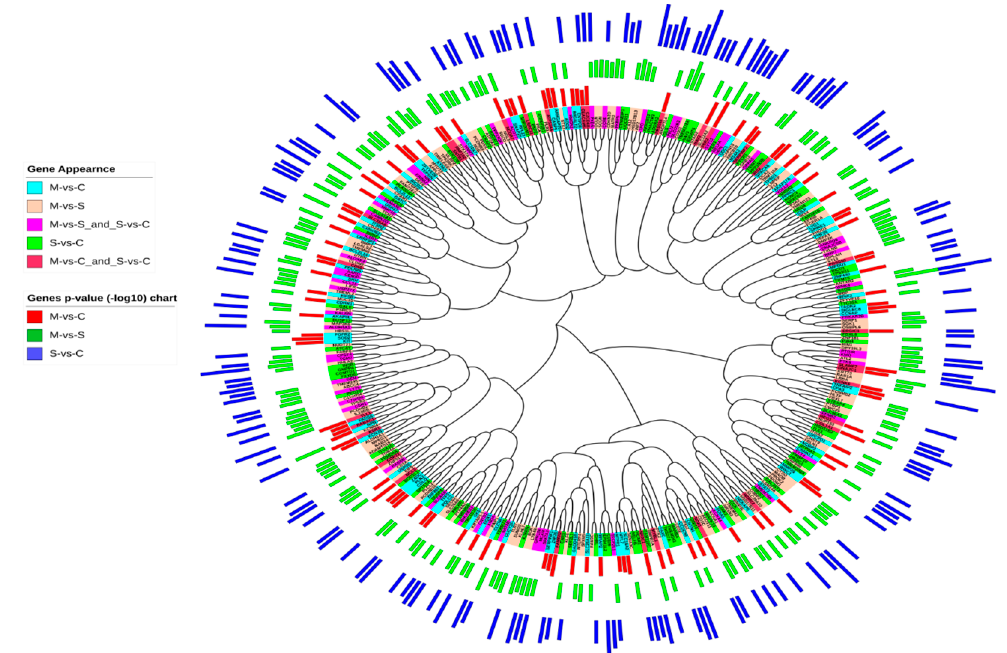
Figure 3. Phylogenetic analysis of genes associated with moderate (M-vs-C), severe (S-vs-C) and moderate-to-severe (M-vs-S) asthma-related genes and intersected genes among these sets, where the p -values of these genes are shown ( − log10).